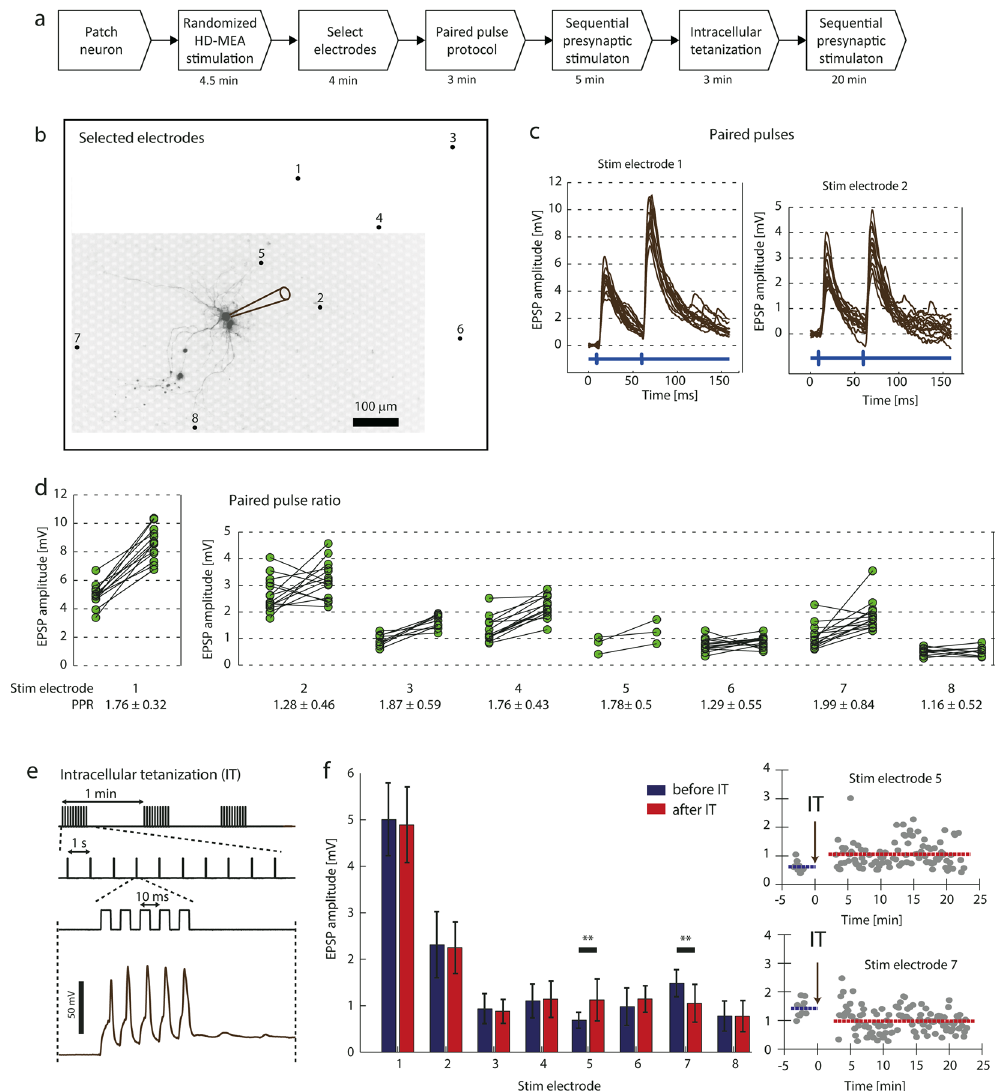
Figure 8. Short- and long-term plasticity measurements for multiple synaptic inputs. ( a ) Experimental steps. ( b ) Fluorescence image of a patched neuron (indicated by the pipette drawing) and position of eight electrodes, which were found to evoke PSPs at the patched cell. ( c ) Individual intracellular traces during application of paired-pulse stimulation through SE 1 and SE 2 (14 trials each). The blue signal at the bottom visualizes the timing of the extracellular stimulation. ( d ) Every connected pair of dots displays the PSP amplitude values for the first and the second evoked PSP upon application of a paired-pulse protocol. If the postsynaptic neuron depolarized before the second PSP peak occurred, the PSP values could not be measured and the trial was ignored for the Figure and PPR calculation. ( e ) Top : Current stimulus used for the intracellular tetanization protocol as described in Methods , consisting of three trains with 10 individual bursts while each burst included five current pulses (0.9 mA amplitude, 5 ms duration) evoking individual APs. Bottom : Five APs evoked by a burst. ( f ) Left : Average PSP amplitudes before and after IT and the corresponding standard deviations indicated by error bars. Right: Individual measured PSP values over the course of the IT experiment for SE 5 and SE 7 . The blue and red lines visualize the average PSP amplitude before and after